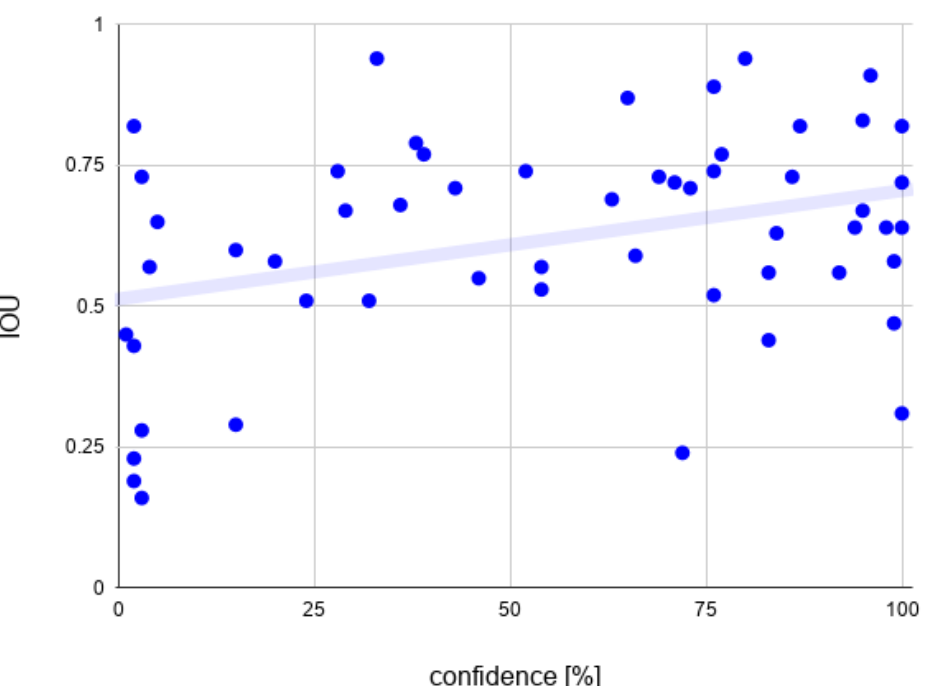
Figure 16. Data points used to calculate the